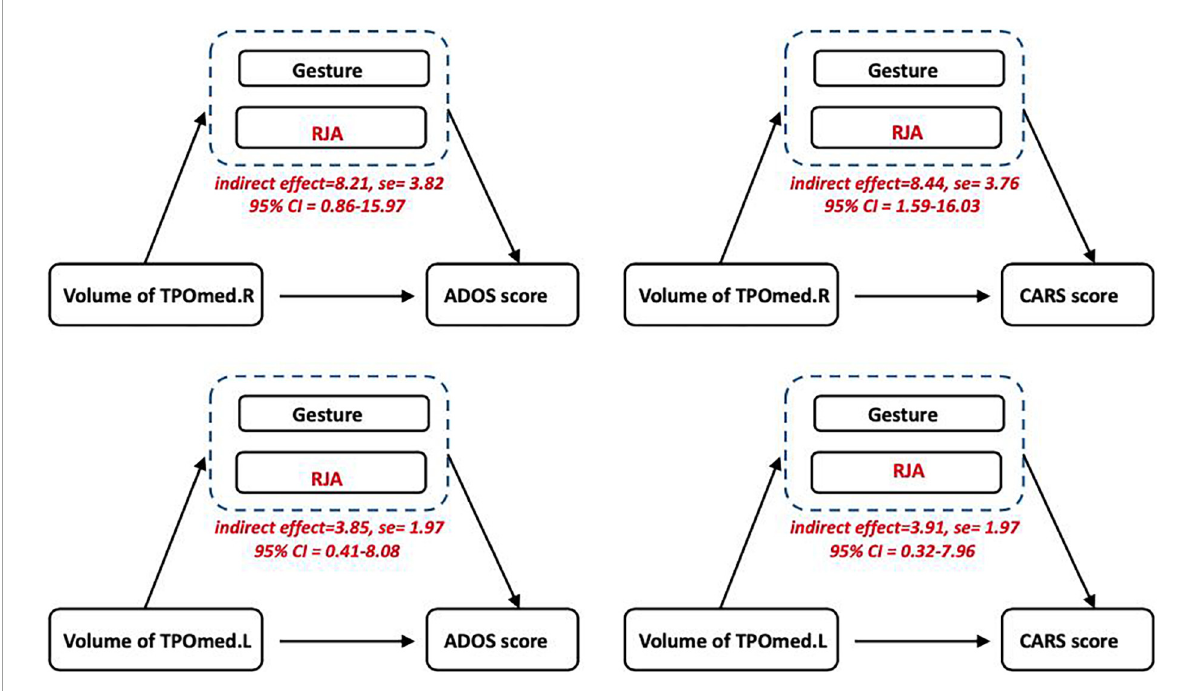
FIGURE3 Relationship among temporopolar volume, language development, and autistic symptoms. The mediation analysis showed an association between the TPOmed volume and ASD severity (CARS and ADOS scores), which was mediated by RJA ability, but not gesture